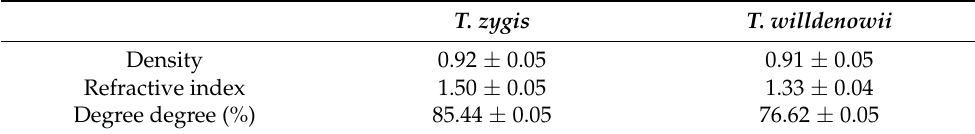
Table 2. Refractive index, degree Brix, and essential oils density of T. zygis and T. willdenowii